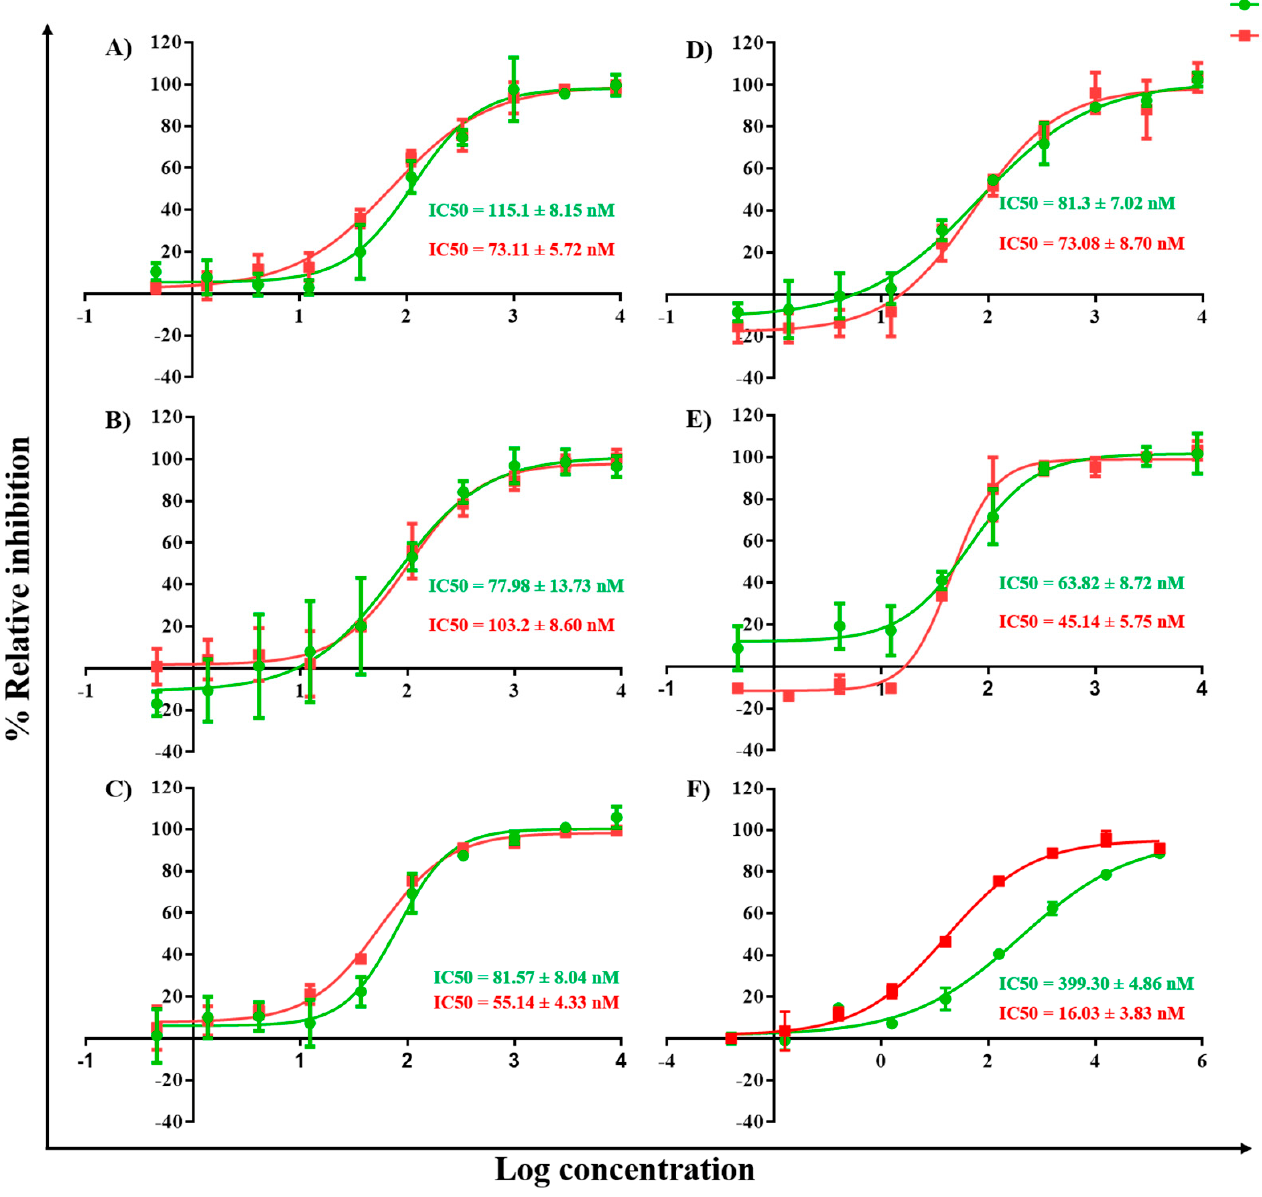
Figure 3. IC50 values of KY DNA aptamers on HIV-1 RTs polymerase activity. The red and green lines represent WT and KY HIV-1 RTs activity, respectively, in the presence of DNA aptamers. ( A ) KY1